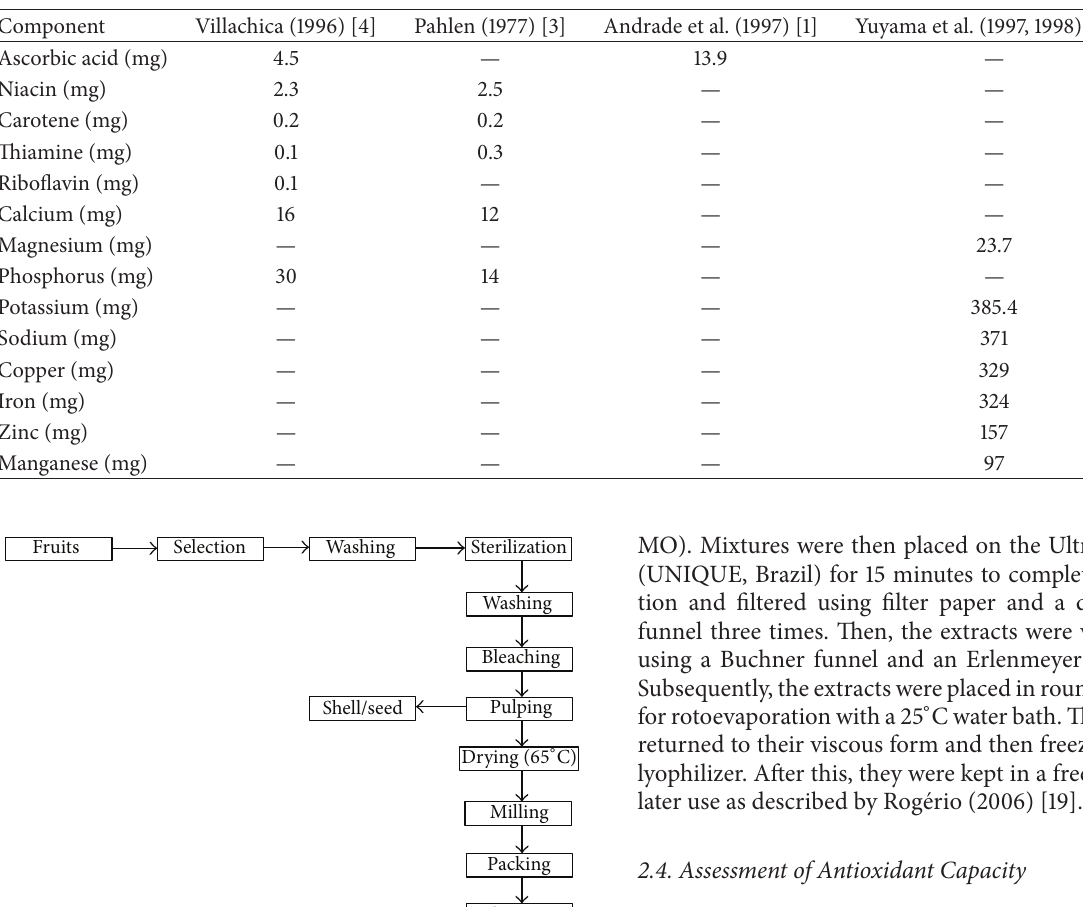
Table 2: Vitamin and mineral composition of Solanum sessiliflorum in 100 g of cubiu whole pulp according to several studies and percentage of the daily recommendation of the National Research Council (1989) [14].